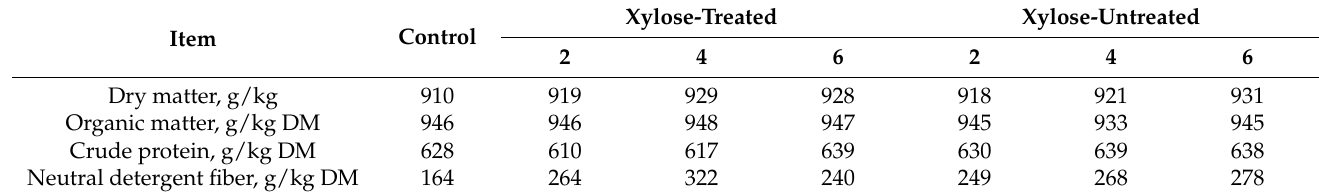
Table 3. Chemical composition of experimental ingredients for Experiment 3—Microwave